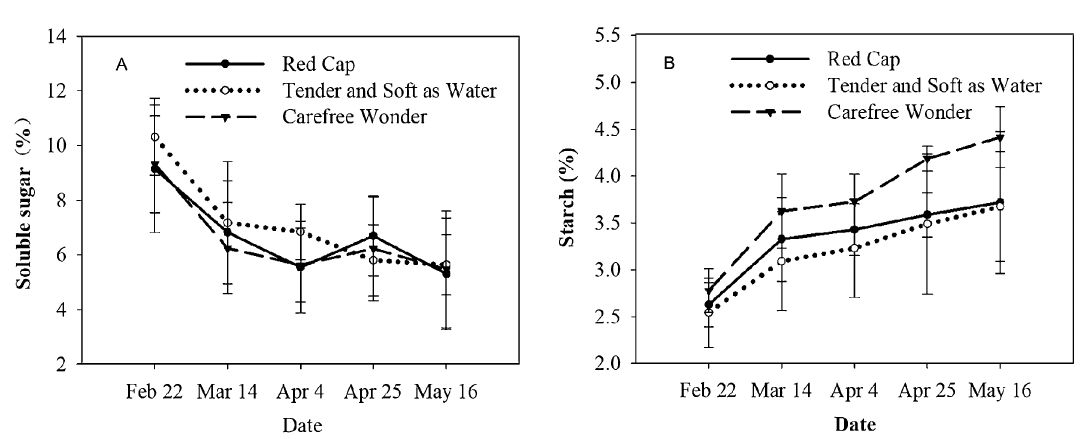
Figure 3. Soluble sugar content ( A ) and starch content ( B ) in the stems of three floribunda rose ( Rosa hybrida ) cultivars under natural conditions during the dehardening